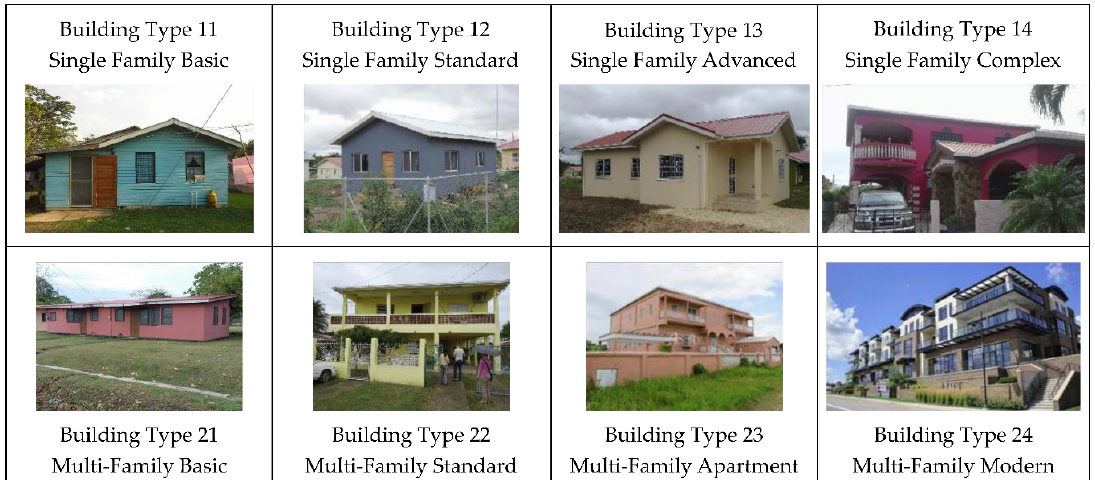
Figure 5. The proposed building typology adapted to the case city Belmopan, Belize. Upper row representing single family buildings, lower representing multi-family buildings. Image sources Building Type 23: [88].